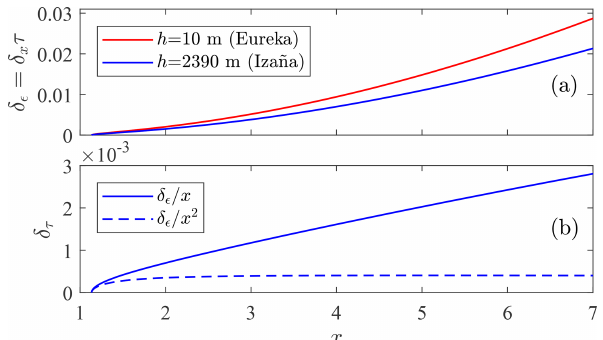
Figure 13. (a) Assessment of accuracy associated with air mass miscalculation errors for a descending star (same conditions as Fig. 12). Panel (b) shows δ τ in the case of Izaña site (where δ τ = τδ x /x = δ (cid:15) /x ); δ (cid:15) /x 2 shows δ x dependency in x 2